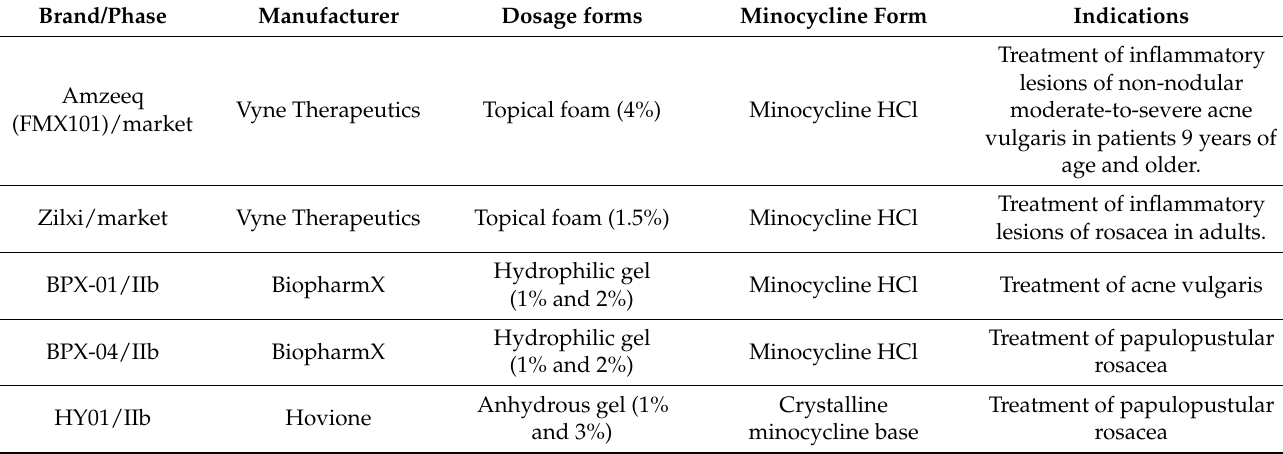
Table 4. Description of topical minocycline formulations commercially available or under clinical